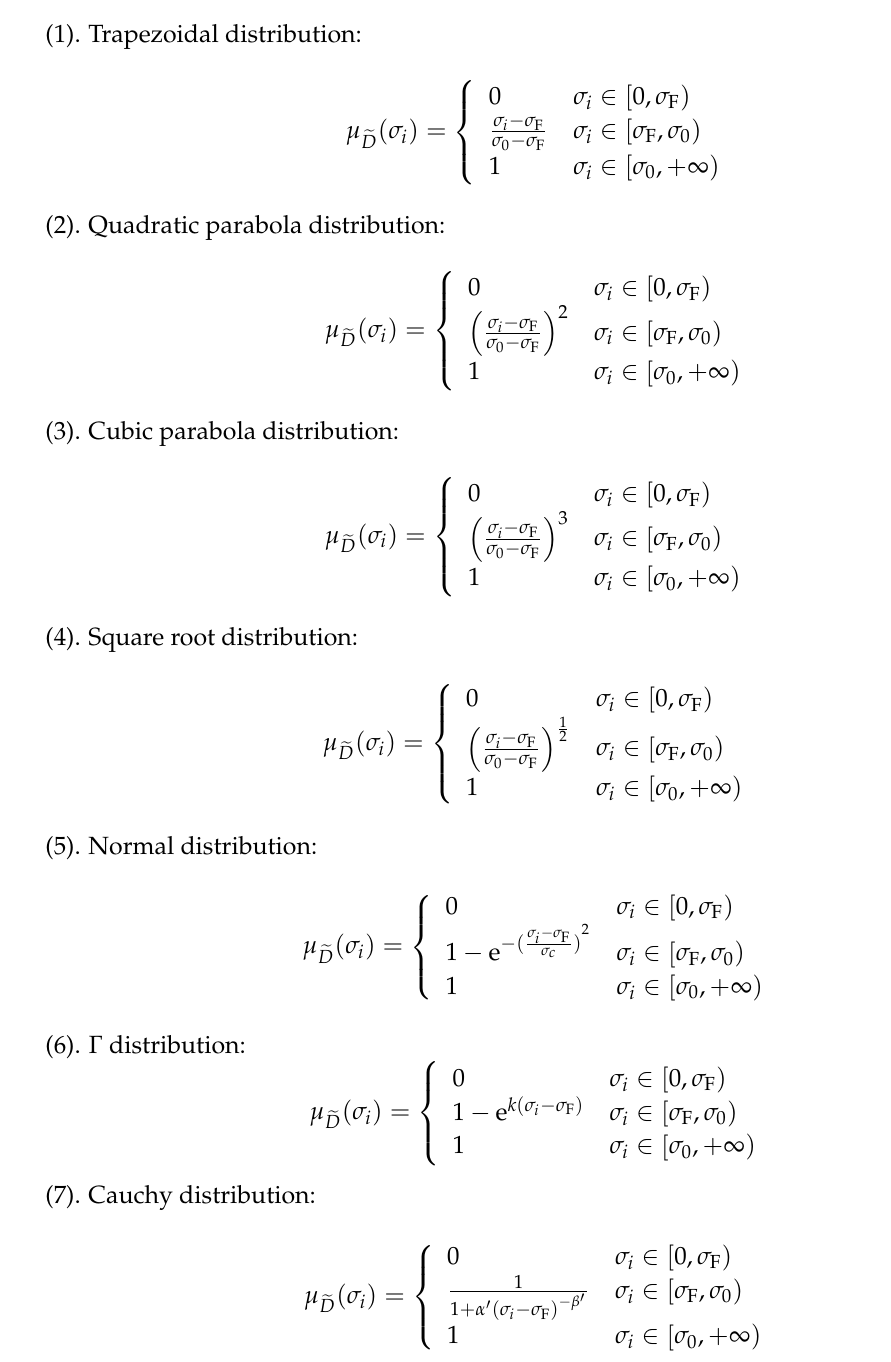
in Figure 4. The MFs can be sorted into three categories: (1) linear (the Trapezoidal MF), (2) concave (the Quadratic parabola MF and the Cubic parabola MF) and (3) convex (the Square root, the Normal, the Γ and the Cauchy MFs). The accumulated damage (Equation (24)) of the i th loading cycle consists of two parts: (1) the cumulative damage from the ( i − 1)th cycle, and (2) the damage caused by the ith load. The total damage can be obtained by multiplying the MF, the strengthening coefficient and